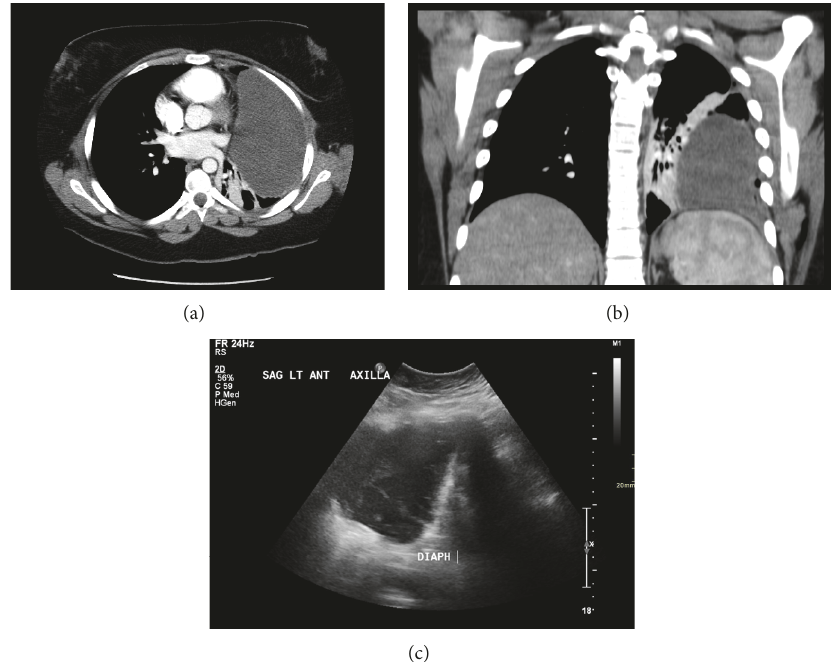
Figure 1: (a) Contrast enhanced axial image through upper thorax demonstrates a complex left pleural fluid collection with heterogeneous attenuationand internalseptations. No vascularity was demonstrated to suggest and underlying mass. (b) Coronal image demonstrate partial collapse of the lower and upper lobes due to mass effect from the pleural collection. (c) Sonographic image through the left hemidiaphragm shows a mildly complex pleural fluid